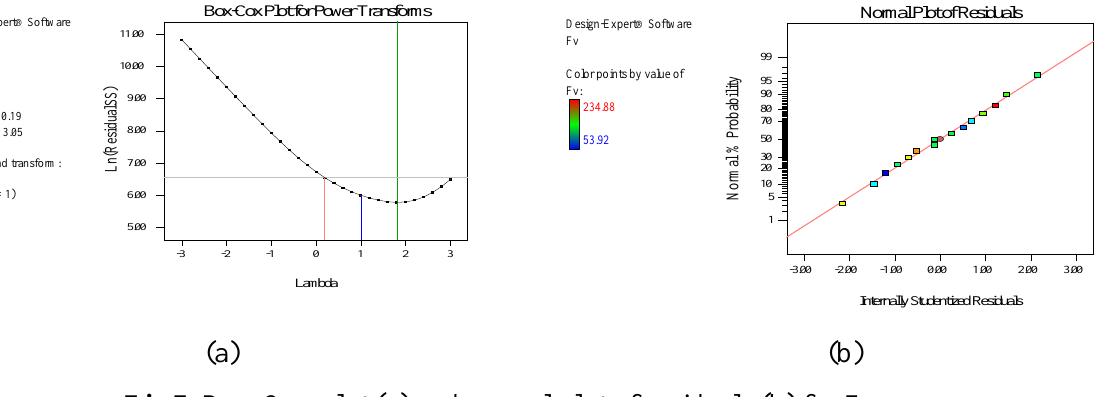
Fig. 6. Box-Cox plot (a) and normal plot of residuals (b) for Fr